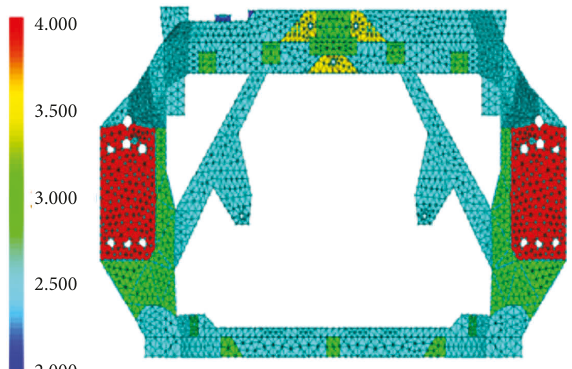
Figure 3: Mesh model thickness diagnosis